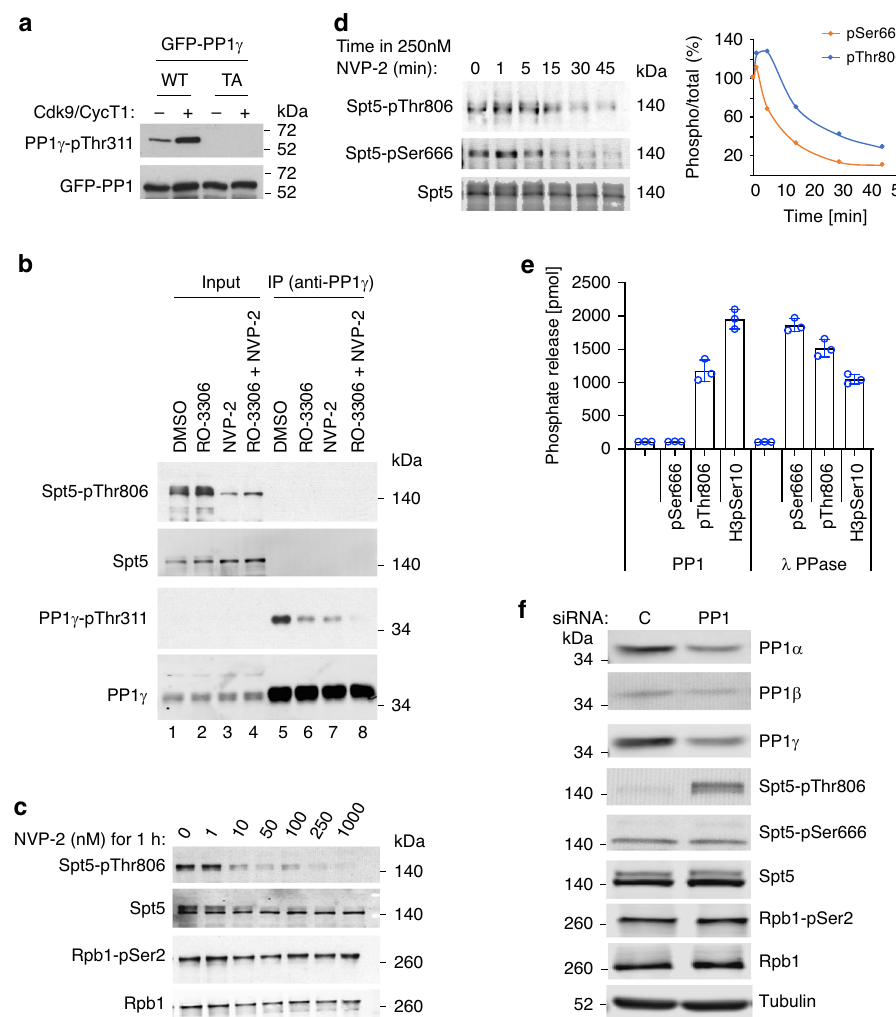
Fig. 1 A Cdk9-PP1 switch governing Spt5 phosphorylation is conserved in human cells. a Puri fi ed, recombinant Cdk9/cyclin T1 phosphorylates wild-type (WT) GFP-PP1 γ , expressed in human cells and recovered by anti-GFP immunoprecipitation, but not a Thr311 → Ala (TA) mutant variant. Phosphorylation was detected with antibody speci fi c for the carboxy-terminal phosphorylation site (Thr320) in PP1 α isoform, analogous to Thr311 of PP1 γ . b Inhibition of Cdk9 or Cdk1 diminishes PP1 γ -inhibitory phosphorylation in human cells. HCT116 cells were treated with DMSO, a Cdk1 inhibitor (RO-3306), a Cdk9 inhibitor (NVP-2), or both, as indicated. Extracts were analyzed by direct immunoblotting (lanes 1 – 4), or anti-PP1 γ immunoprecipitation (IP) followed by immunoblotting (lanes 5 – 8), with the indicated antibodies. c Cdk9 inhibition diminishes phosphorylation of Spt5-Thr806 but not Ser2 of the Pol II CTD. HCT116 cells were treated with the indicated concentrations of NVP-2 for 1 h and extracts were immunoblotted with the indicated antibodies. d HCT116 cells were treated with 250 nM NVP-2 for indicated times and extracts were immunoblotted with antibodies speci fi c for Spt5, Spt5-pThr806, and Spt5- pSer666, as indicated. Immunoblot ( n = 1) signals were quanti fi ed with ImageJ software. e Spt5-derived phosphopeptides containing pSer666 or pThr806 or a control histone H3-derived phosphopeptide containing pSer10, as indicated, were incubated with puri fi ed PP1 or lambda phosphatase, as indicated, and phosphate release was measured colorimetrically. Individual data points are shown from three biological replicates ( n = 3); error bars indicate ±standard deviation (±s.d.) from mean. f HCT116 cells were transfected with an siRNA cocktail targeting all three PP1 catalytic-subunit isoforms or a scrambled control (C) siRNA, as indicated, and extracts were immunoblotted for the indicated proteins or protein modi fi cations. Experiments were performed twice with similar results ( a – c , f ). Source data are provided as a Source data fi le. Uncropped blots can be found in the Supplementary